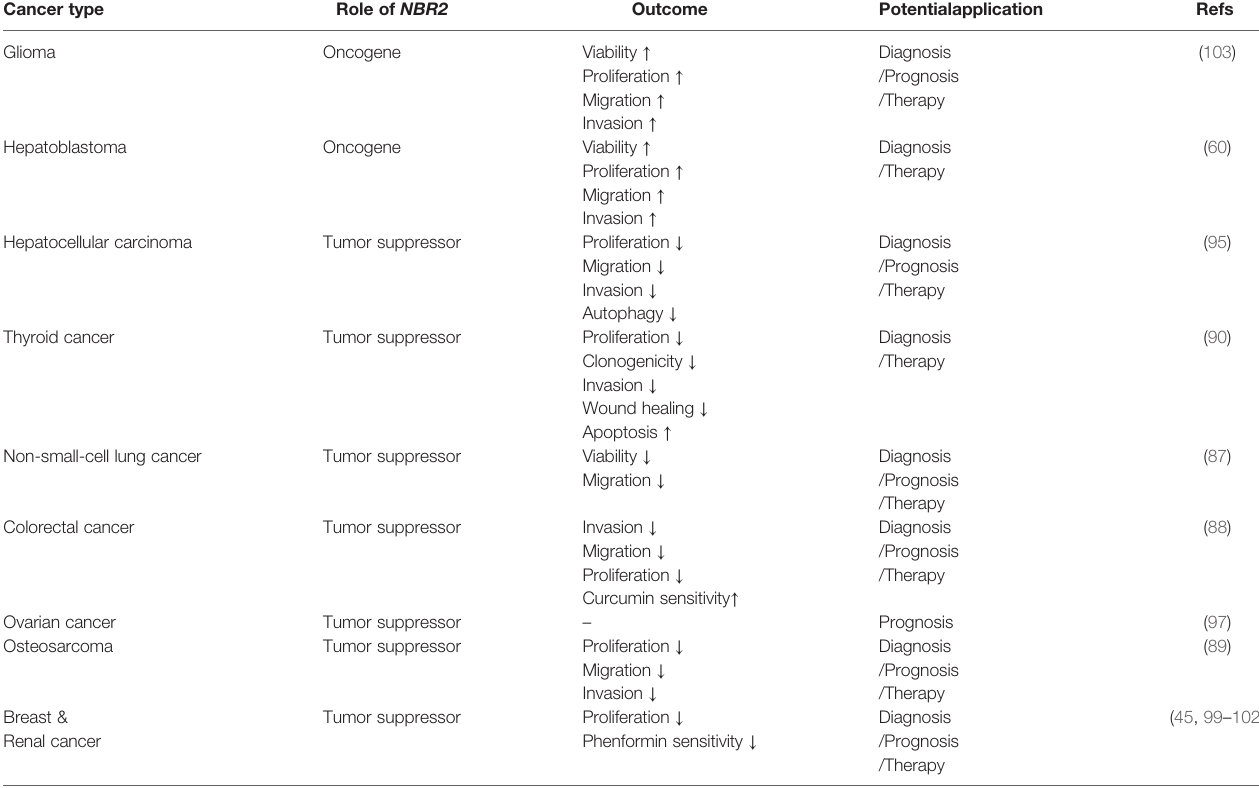
TABLE 1 | Clinical applications of NBR2 in